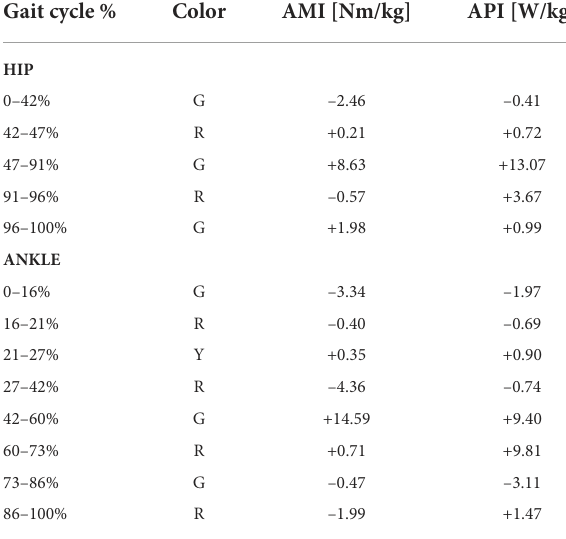
TABLE 3 Gait cycles of the hip and the ankle with their percentage